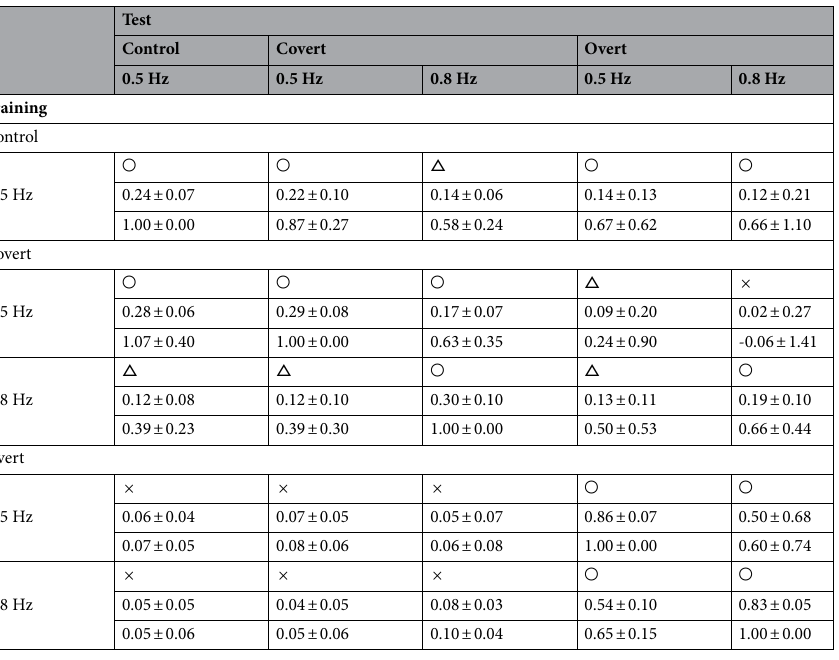
Table 2. Summary of generalization abilities among tasks. The upper field of each cell indicates a comprehensive evaluation. Middle fields indicate the mean and standard deviation calculated from original determination coefficients for the reconstructed position and velocity data. Lower fields indicate those calculated from normalized determination coefficients. We chose each symbol in the upper field based on normalized coefficients of determination shown in the lower fields. Circle, triangle, and cross represent high- (≥ 0.6), middle- (≥ 0.2), low-generalization abilities (< 0.2), respectively. The statistical analysis and data about normalized determination coefficients are shown in Supplementary Information